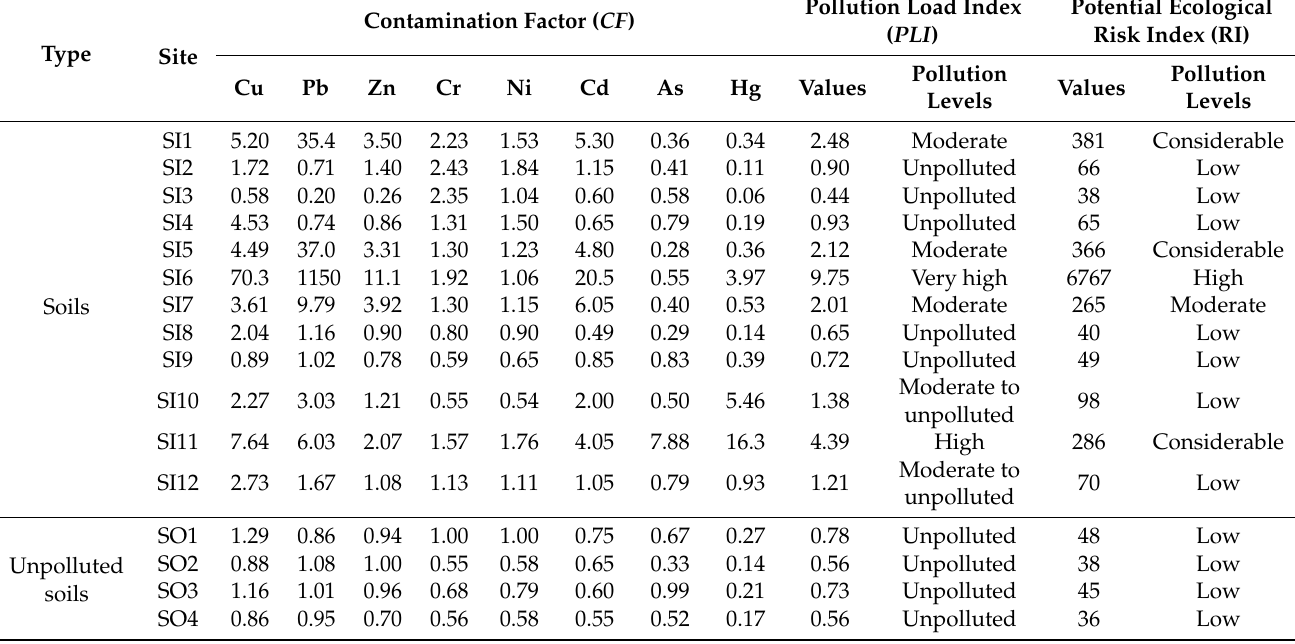
Table 2. Pollution assessment of PTEs in soils and